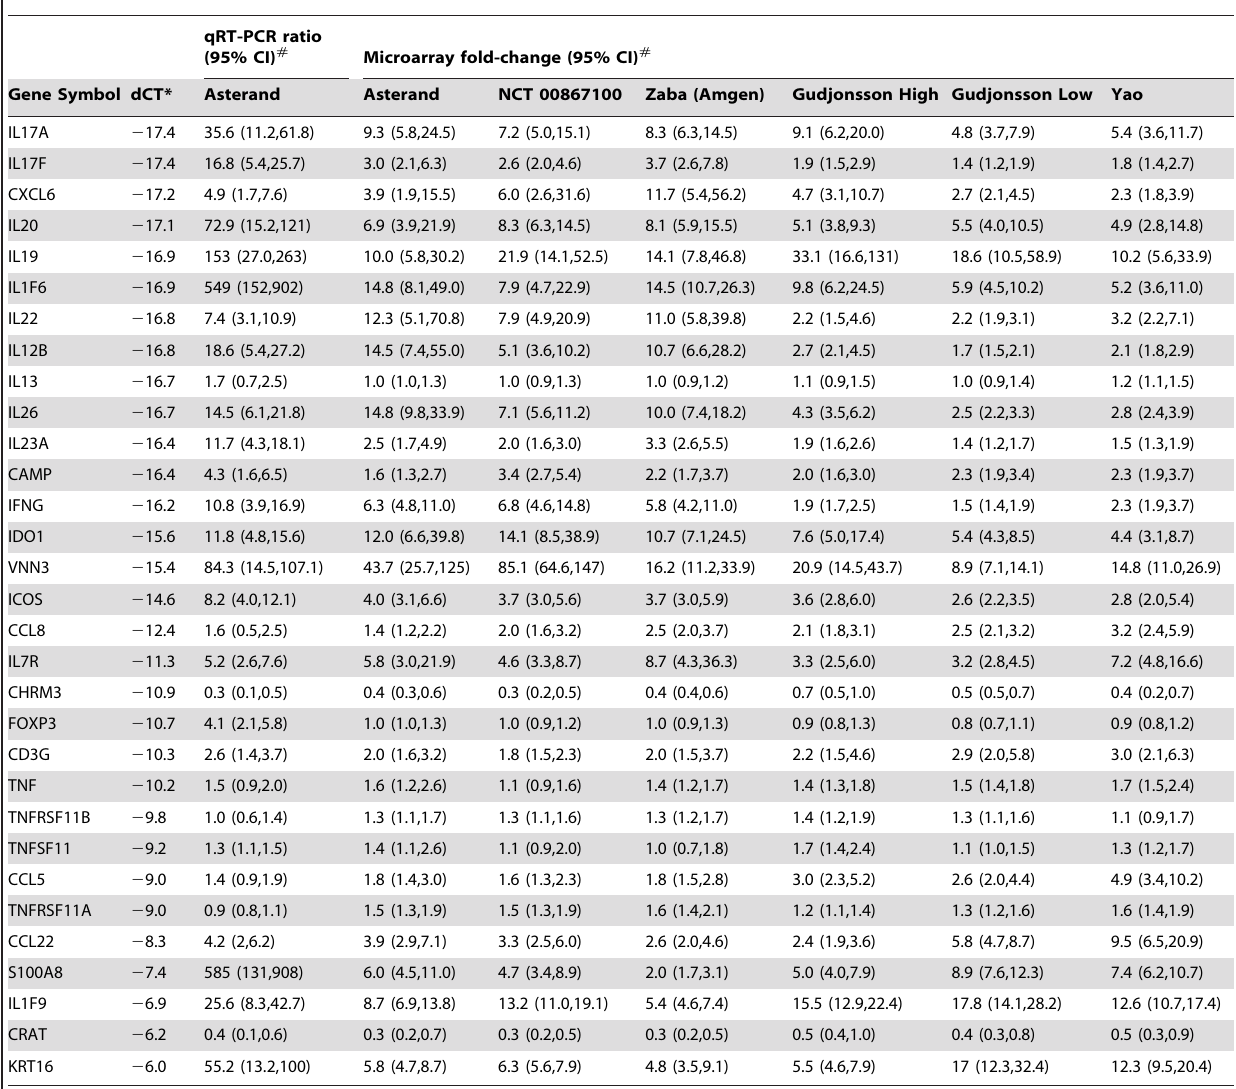
Table 2. Fold-Changes Derived from Comparing PP and PN Skin Samples for Selected Probe Sets Across Data Sets and